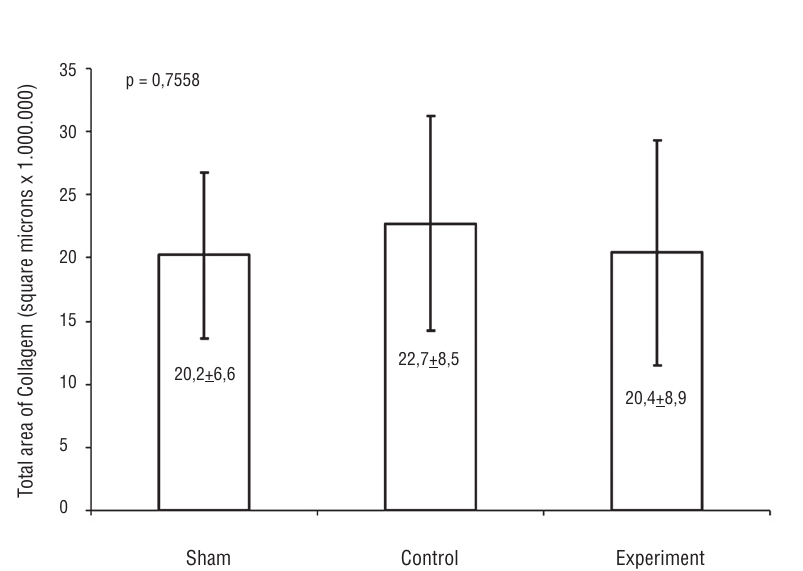
Figure-1 - Means and standard deviations areas of total